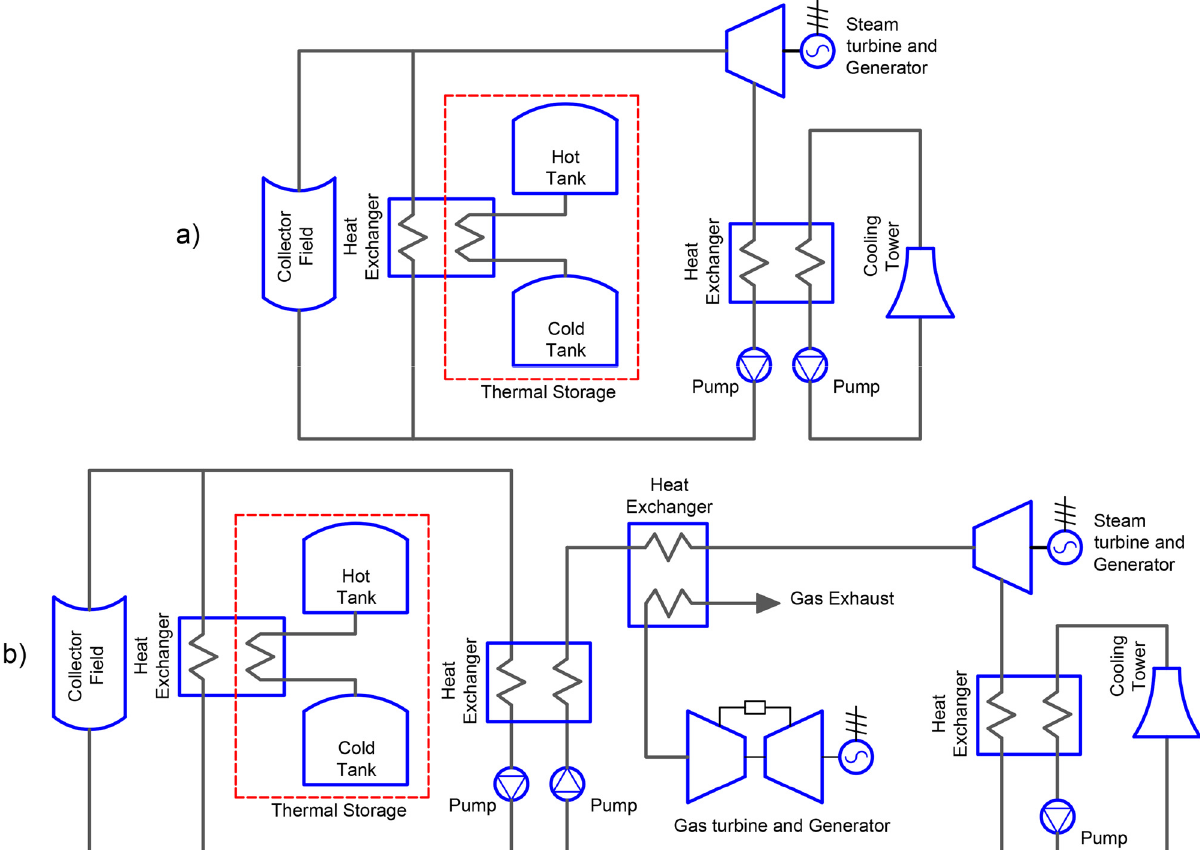
Figure 11: CSP plant diagrams: ( a ) direct SG, ( b ) indirect SG integrated with a combined